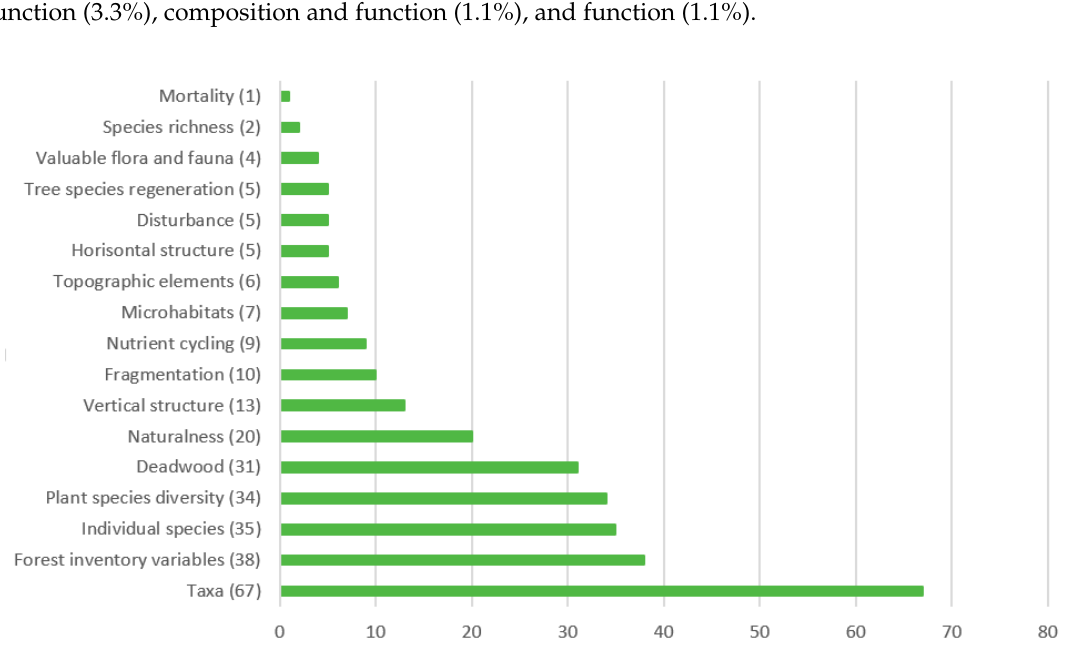
Figure 5. Number of biodiversity indicators used in reviewed studies. For details how indicators are explained and sorted by type of biodiversity (structure, composition, and function) see supporting material, Table S2.